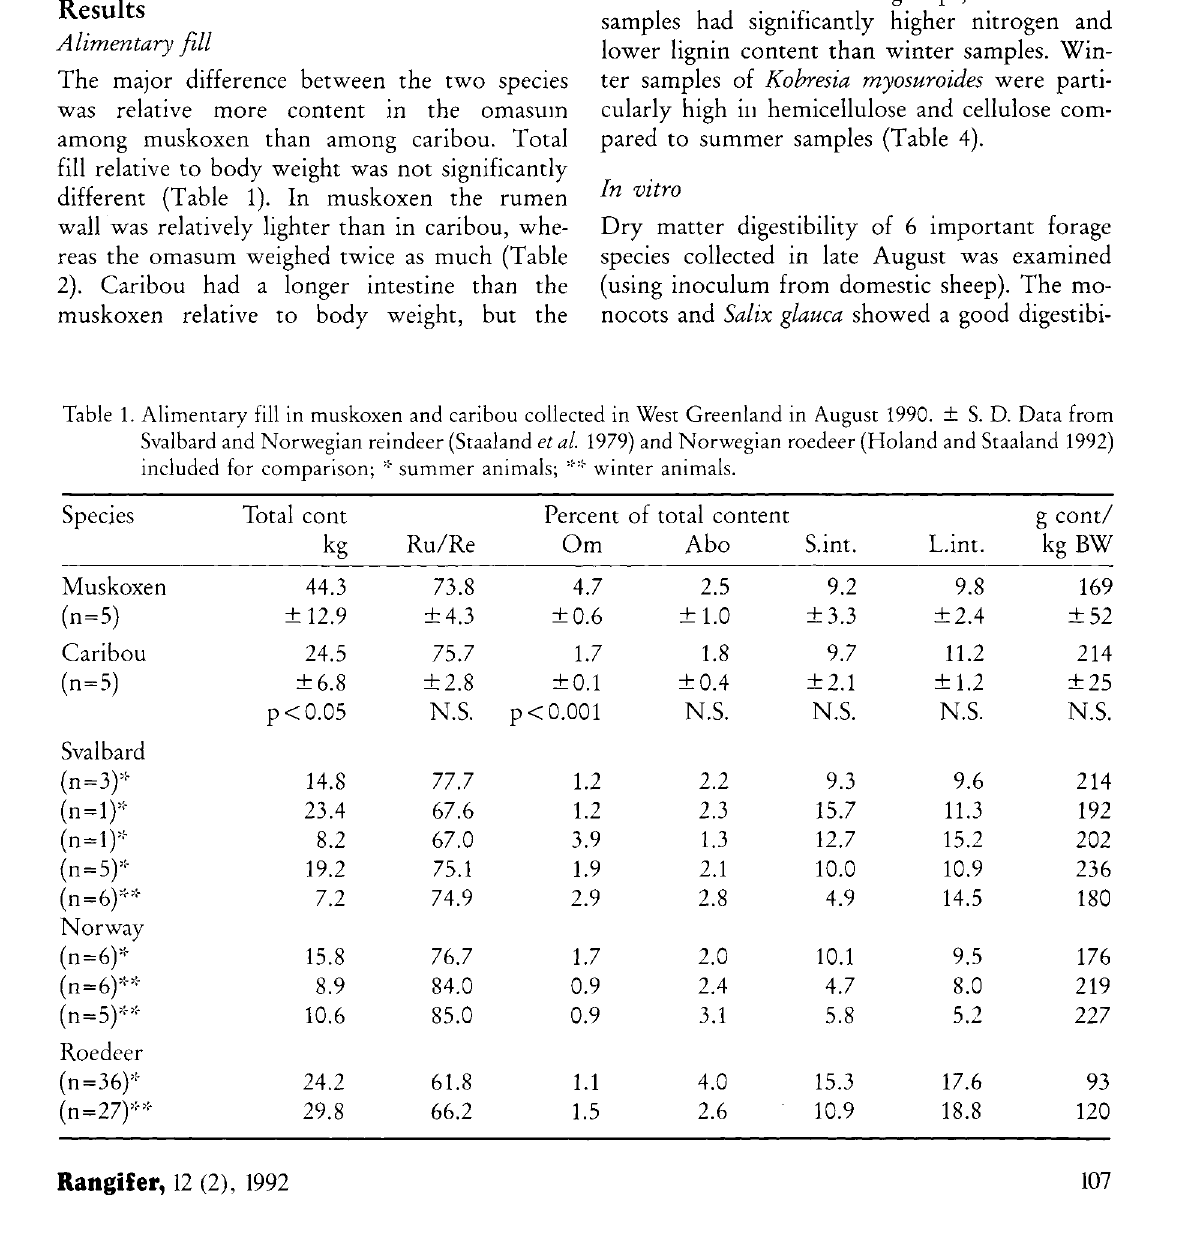
Table 1. Alimentary fill in muskoxen and caribou collected in West Greenland in August 1990. ± S. D. Data from Svalbard and Norwegian reindeer (Staaland et al 1979) and Norwegian roedeer (Holand and Staaland 1992) included for comparison; * summer animals; ** winter